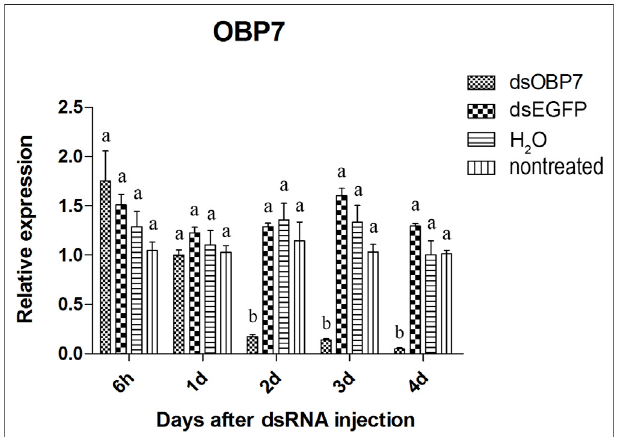
FIGURE4| Relativeexpressionof LWopsin1 inEABadultsafterdsRNA injection.Relativeexpressionof LWopsin1 byRT-qPCRassaywasevaluated 6 hours, 1, 2, 3 and 4 days after injecting 3 µg dsRNA. TEF-1 α was used as a reference gene for normalization. Means ± SE (n = 4) are shown. StatisticalanalyseswereperformedusingANOVA/LSDmethodat p < 0.05for comparison among treatments. Statistical differences are shown by different letters between different treatments at the same time point.